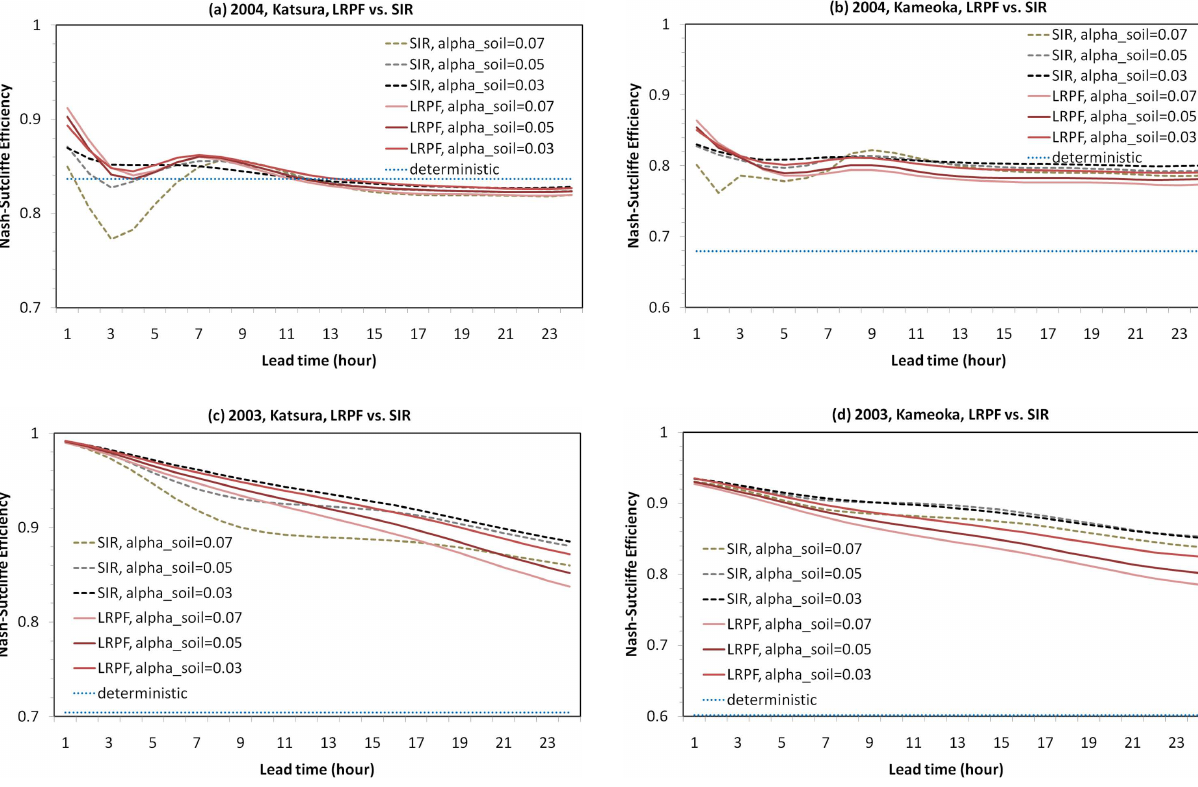
Simulation periods and observation are shown in Table